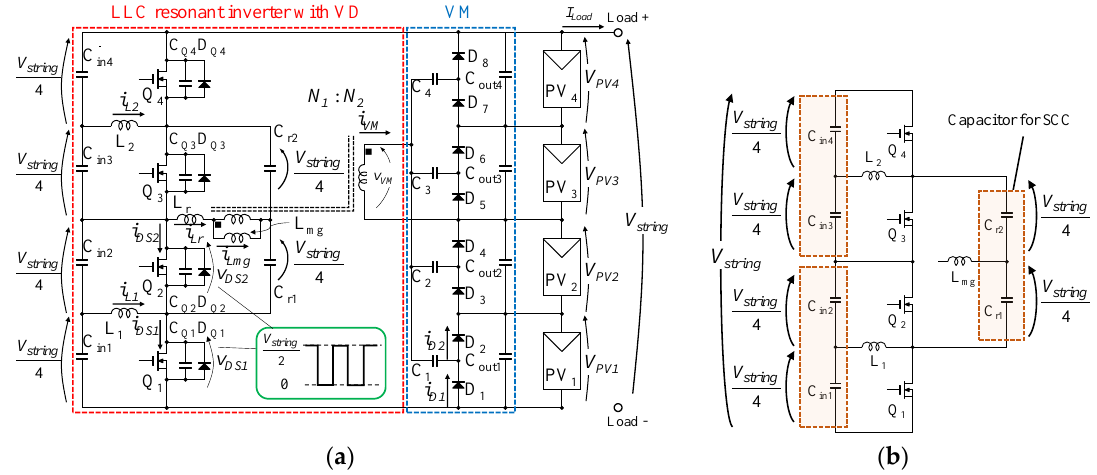
Figure 5. ( a ) Proposed DPP converter based on voltage divider (VD) and LLC resonant voltage multiplier (VM); ( b ) Voltage divider.